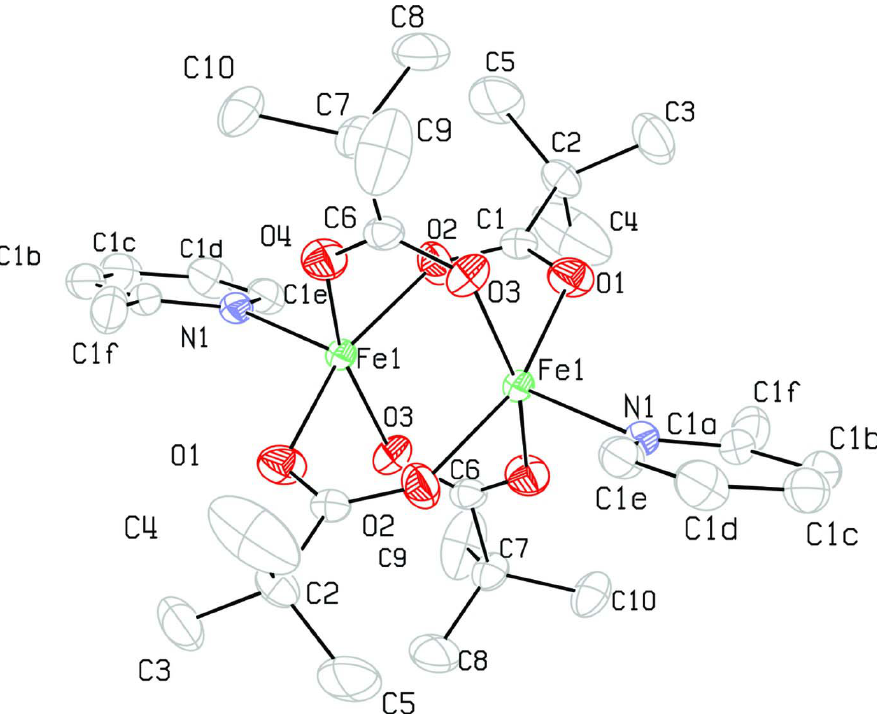
Figure 1 ORTEP drawing (Johnson, 1976) of (1) showing the atomic labelling scheme. Hydrogen atoms are omitted for clarity. The thermal ellipsoids show 50% probability